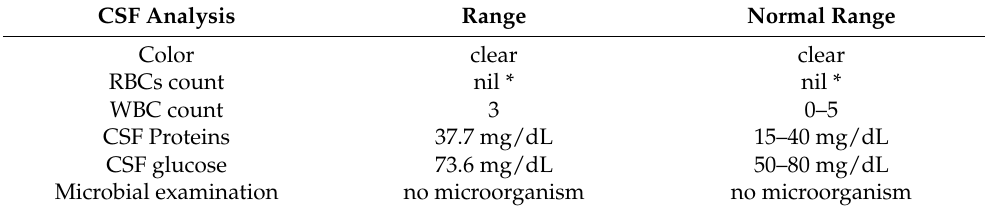
Table 1. CSF analysis.